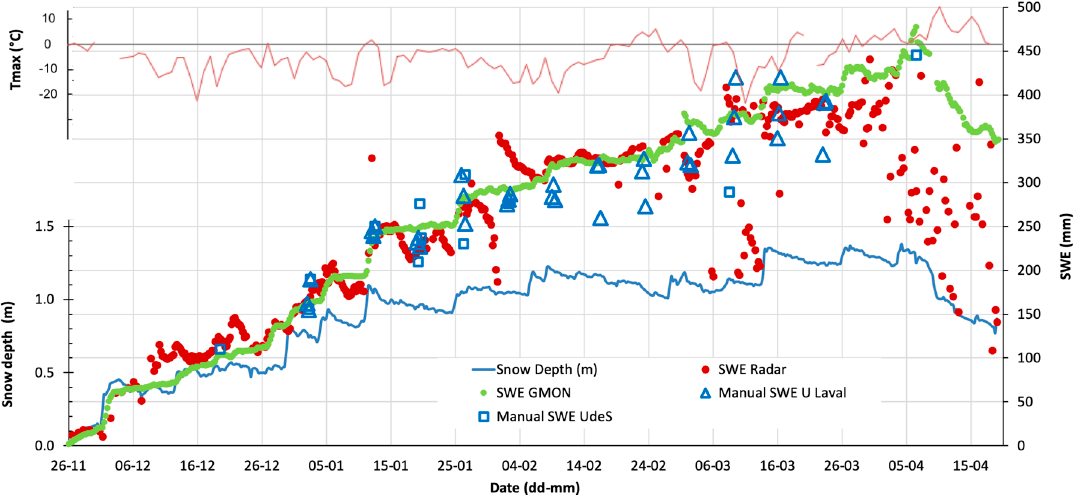
Figure 16. Time variations in snow depth (m) (blue line, left axis) and SWE (mm) (right axis) from the GMON sensor (green line), the radar sensor (red points) and in situ measurements (open blue squares and triangles) around the GMON-radar site at NEIGE-FM. The mean daily maximum air temperature (Tmax) (thin red line) is overlaid (upper left axis). In situ measurements were performed by two teams from Université de Sherbrooke (UdeS) and Université Laval. Measurements were made during winter 2016–2017.